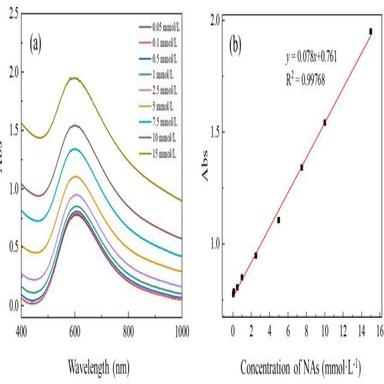
(a) UV–Vis spectrum of the model NAs with different concentrations; (b) linear relationship 0.05–15 mmol⋅L− 1 between the concentration of model NAs to absorbance.